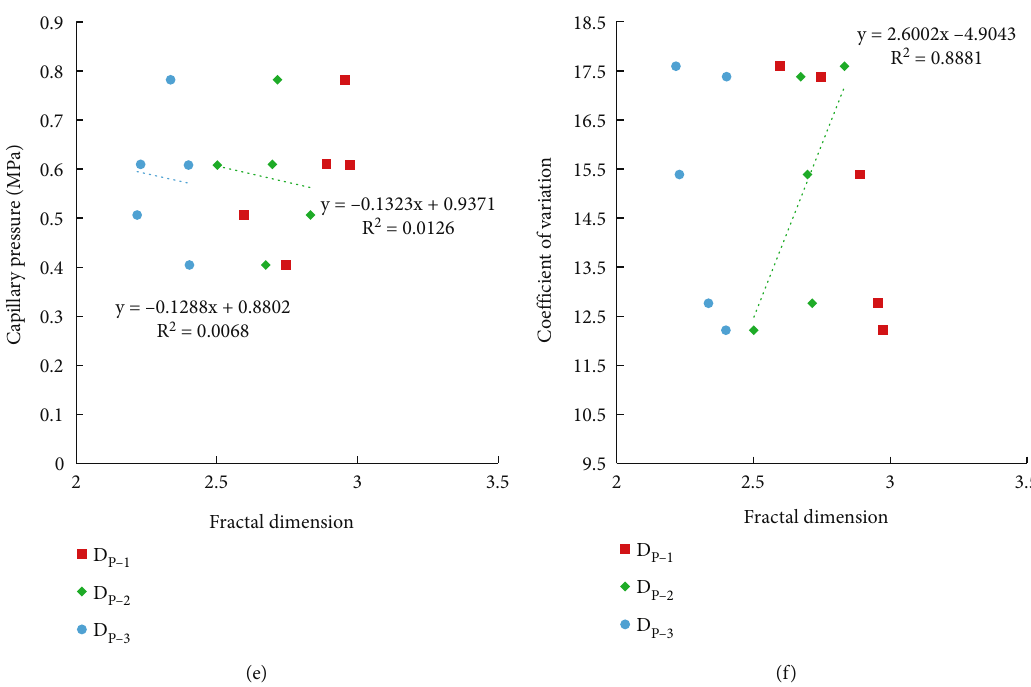
Figure 9: Fractal dimension versus median pore-throat radius (a), sorting coe ffi cient (b), maximum mercury saturation (c), e ffi ciency of mercury withdrawal (d), capillary pressure (e), and variation coe ffi cient (f).